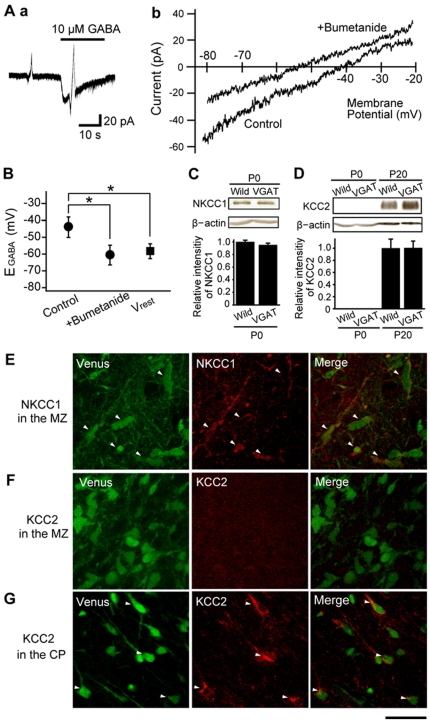
Depolarizing effect of GABA caused by expression of NKCC1.(A) Left panel: Current responses to ramp voltage steps in the absence and presence of 10 µM GABA. Voltage-clamp recordings were performed at a holding potential (VH) of −60 mV, with ramp voltage step pulses from −80 mV to −20 mV with a 3 second duration. Gramicidin perforated patch recordings were done on Venus positive cells using a slice preparation from P0–P3 VGAT Venus mice. Right panel: Samples of GABAAR current-voltage (I–V) curves in control conditions and in the presence of 10 µM bumetanide. EGABA was estimated by the intersection of the voltage axis of each curve. (B) Mean EGABA in control conditions and in the presence of bumetinide. The mean resting membrane potential (Vrest), obtained in current clamp mode, is also shown. The more negative value of Vrest as opposed to EGABA in control conditions indicates a depolarizing effect of GABA (*p<0.05). Bumetanide, a NKCC1 blocker significantly shifted EGABA to more negative values (*p<0.05). n = 5 cells, P0–P3 VGAT-Venus mice. (C) Western blot analysis of NKCC1 and β-actin from the cortex of P0 wild type and VGAT-Venus mouse (n = 3 cortices, respectively). Quantitative analysis of the expression level of NKCC1 were normalized to that of β-actin. (D) Western blot analysis of KCC2 and β-actin from the cortex of P0 and P20 wild type and VGAT-Venus. Quantitative analysis of the expression level of KCC2 were normalized to that of β-actin (n = 3 cortices, respectively). NKCC1 is equally expressed in wild and VGAT-Venus mice, but KCC2 is scarcely detected at P0. Each column indicates mean ± SEM. (E–G) Three horizontal sections containing the MZ (E, F) and the CP (G) from a P0 VGAT-Venus mouse are shown. Sections with Venus fluorescence were counterstained for NKCC1 (E) or KCC2 (F, G). Arrowheads indicate VGAT-Venus positive neurons that were also positive for NKCC (E) or KCC2 (G). Note that NKCC1, but not KCC2, was observed in the MZ (E, F). Scale bar = 30 µm.